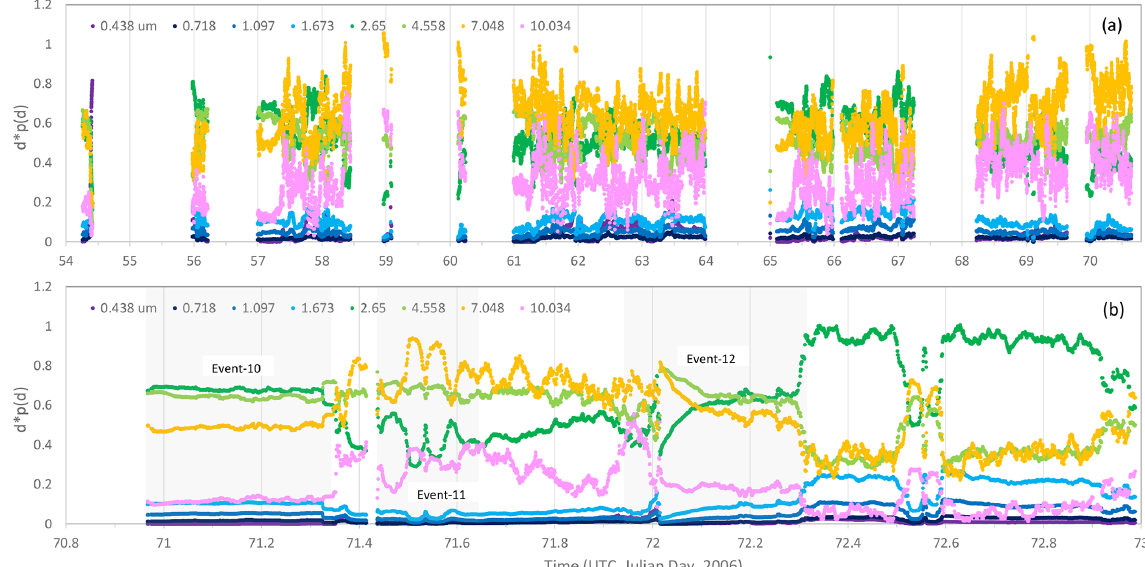
Figure 3. Dust PSD measured at 1m using OPC for the entire JADE observation period plotted in two sections: (a) for section Julian day 54–70.8 and (b) for section Julian day